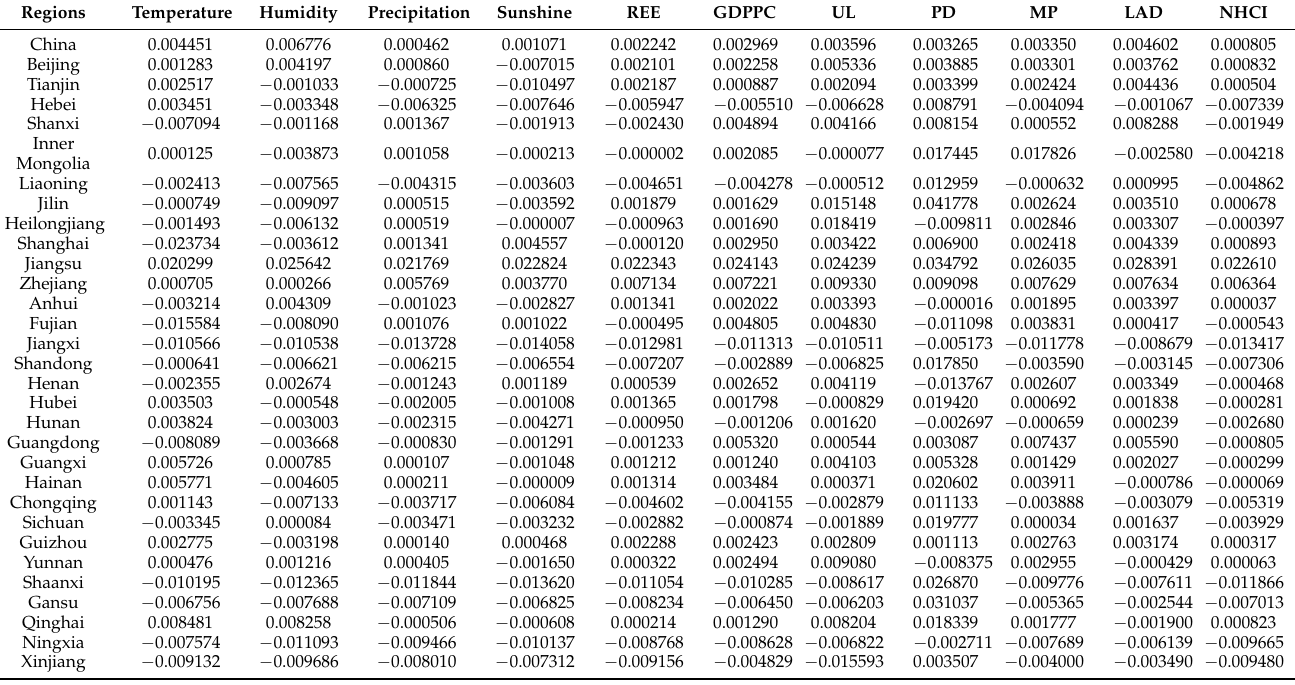
Table 5. How the VTH change when each of variables increases by 1% as X × (1 + 0.01). Regions